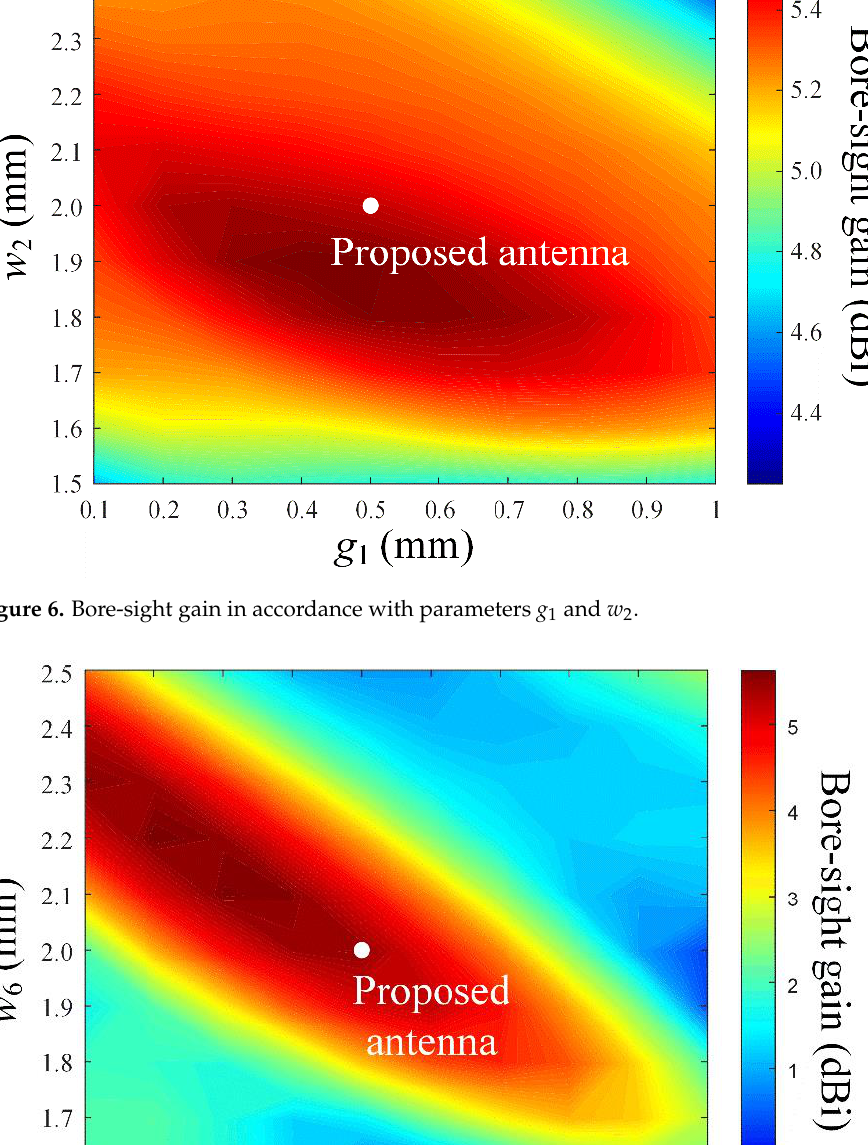
Figure 6. Bore-sight gain in accordance with parameters g 1 and w 2 .